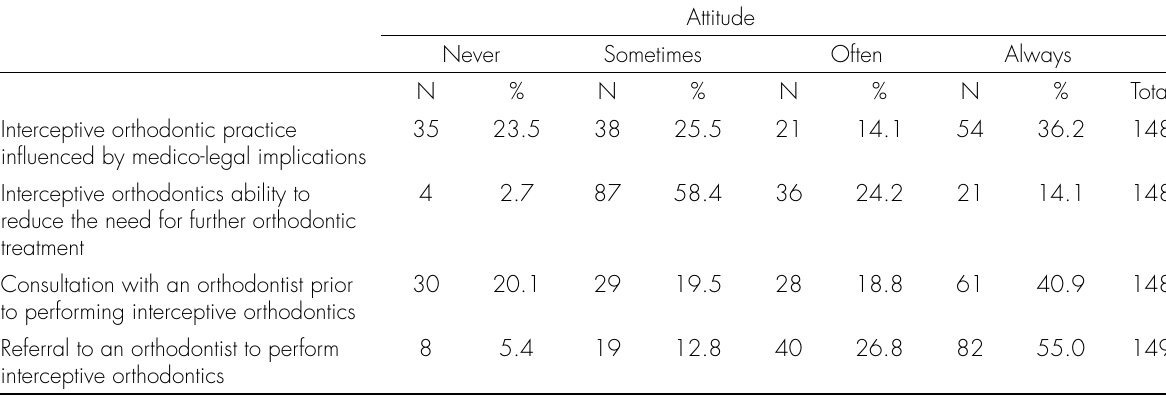
Table IV. General dentists’ attitude and practice in interceptive orthodontics.